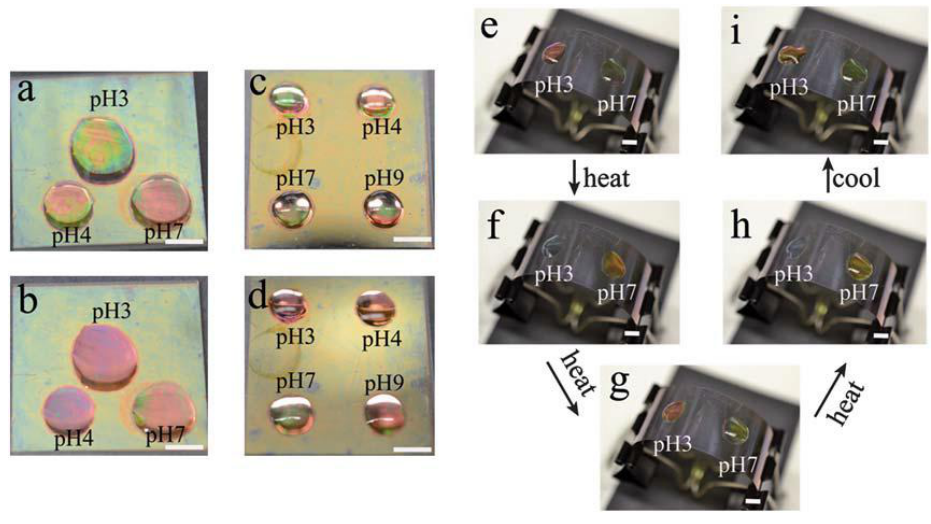
Figure 4. Photographs of an etalon with solutions of various pH’s spotted on a single surface at ( a , c , e , i ) 25 °C and ( b , d , f , g , h ) 37 °C. ( f ) 3 min after heating; ( g ) 5 min after heating; ( h ) 6 min after heating. In each panel, the scale bar is 5 mm. Reproduced with permission from